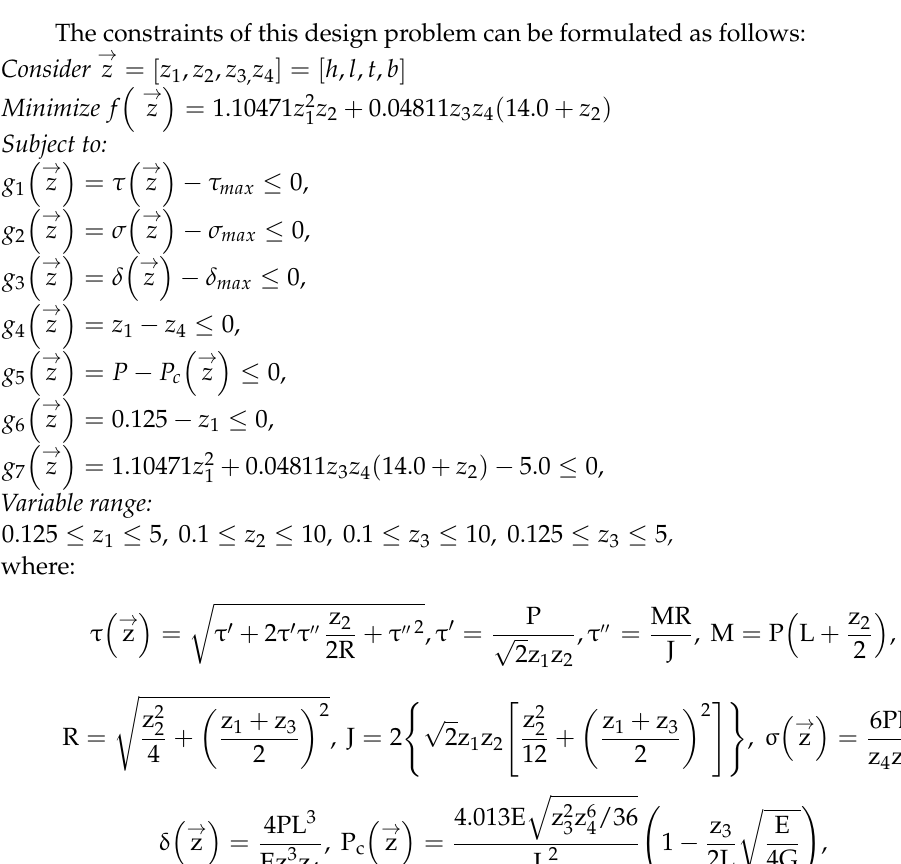
Figure 11. Schematic view of the welded beam